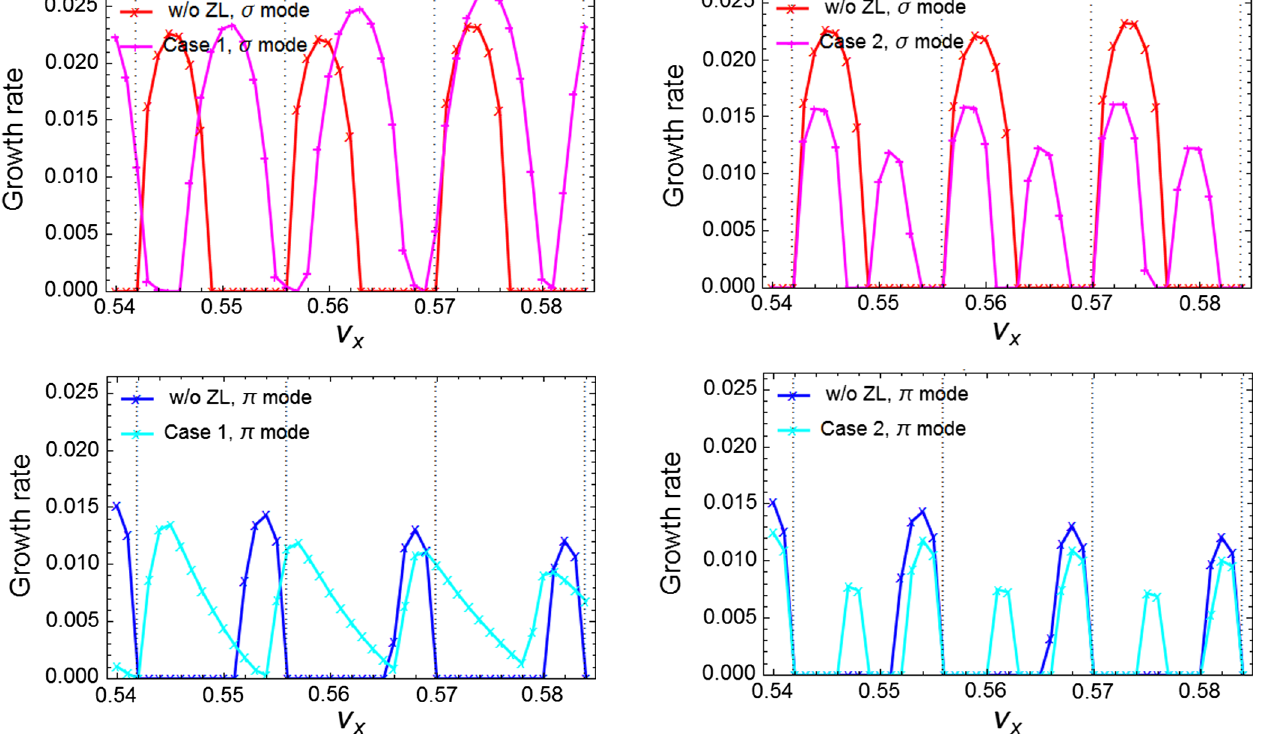
FIG. 14. Eigenvalues of σ mode (left) and π mode (right) as a function of bunch population, where ν no distortion of elliptical trajectory but keep the incoherent synchrotron tune